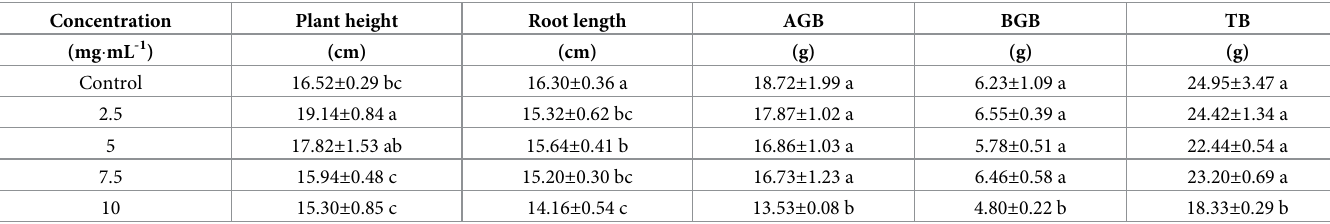
Note . Value ± SE with ANOVA results ( n = 3). Different letters represent significant differences between different concentration ( P < 0.05; Tukey’s test). AGB: aboveground biomass, BGB: belowground biomass, TB: total